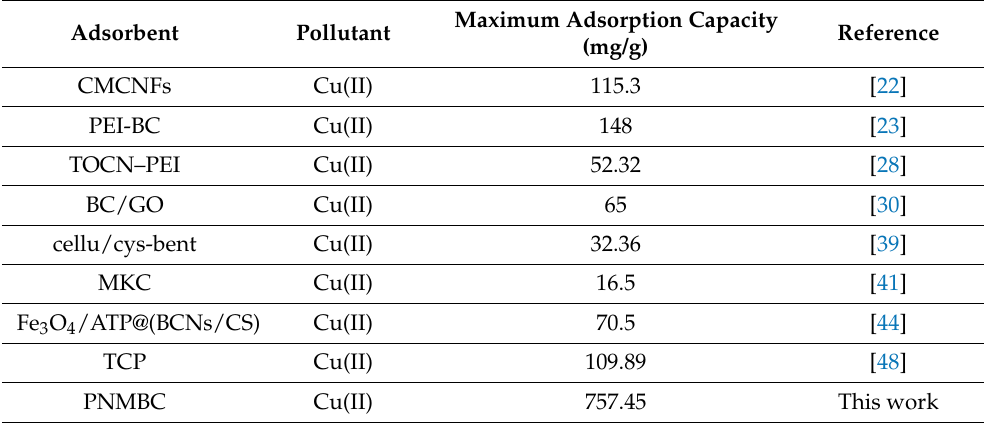
Figure 9. Effect of different initial concentrations of Cu(II) adsorption at ( a ) 15 ◦ C, ( b ) 25 ◦ C, and ( c ) 35 ◦ C. Table 1. The Cu(II) adsorption capacity of nanocellulose-modified and bentonite-based adsorbents obtained from the literature.